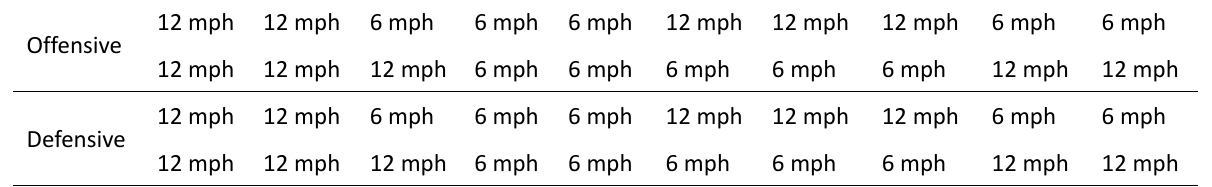
Table 1. The CAT measurements at different stimulus speeds measured randomly according to playing positions